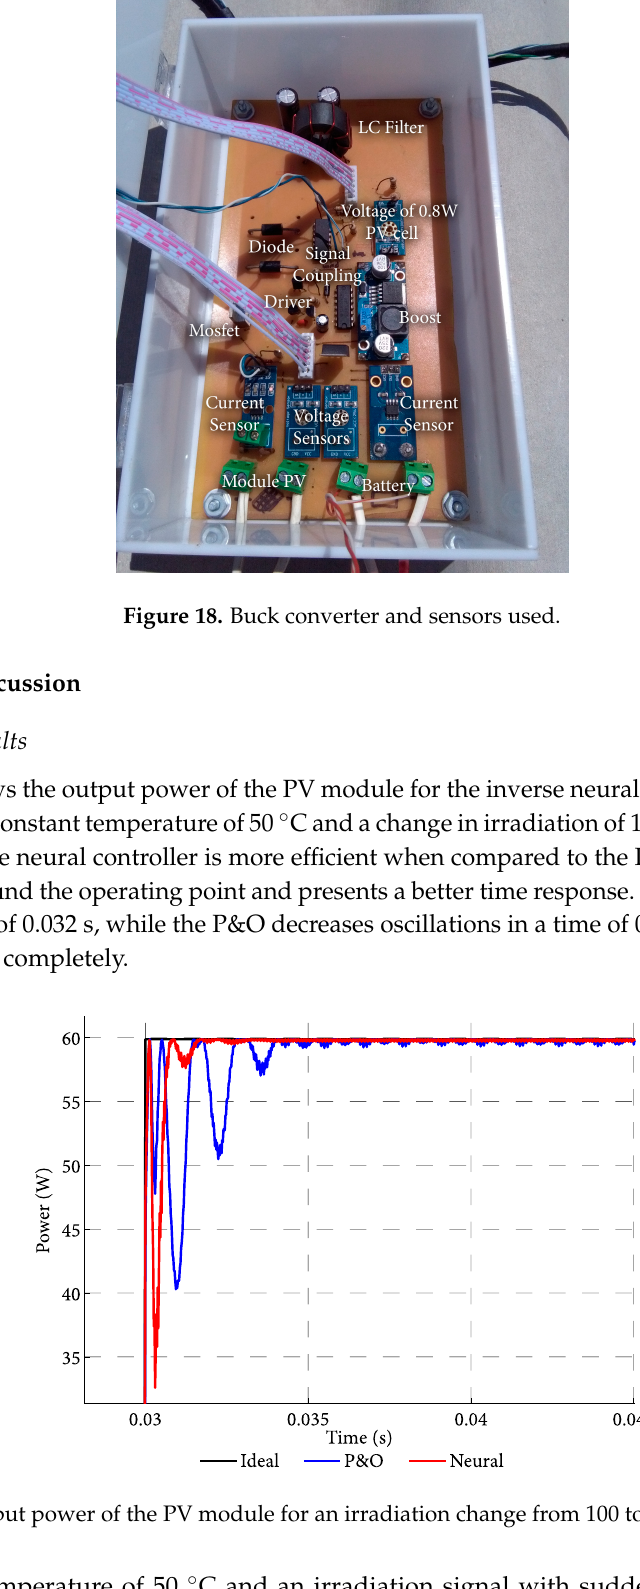
Figure 17. PV system hardware.